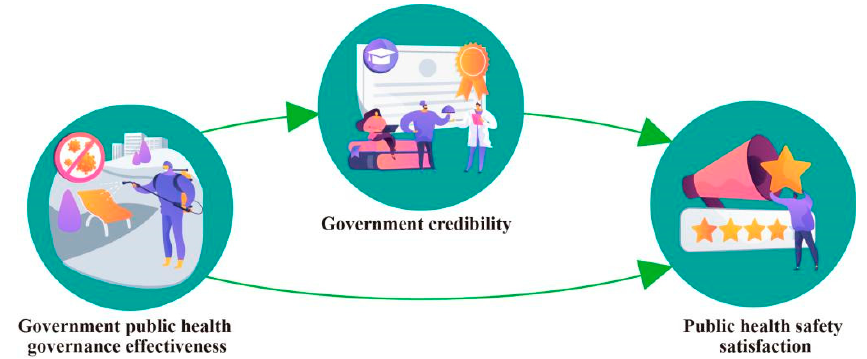
Figure 1. Schematic diagram of research model.